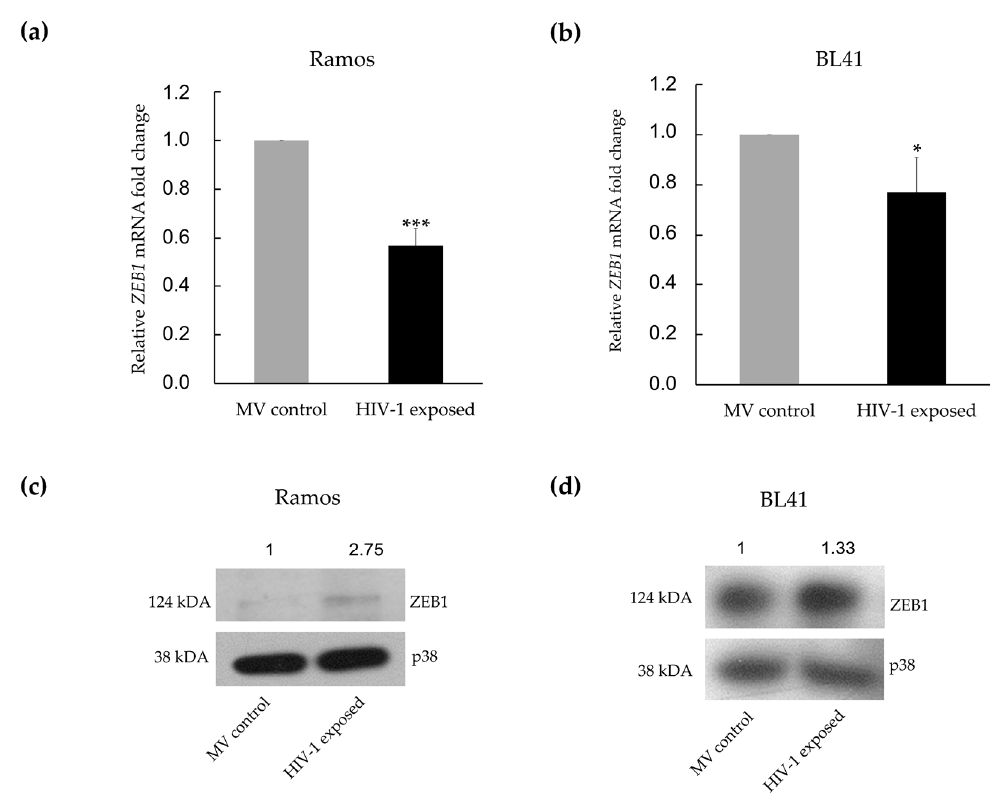
Figure 4. HIV-1 AT-2 deregulates expression of ZEB1 in BL cells. The cells were treated with either HIV-1 AT-2 or microvesicles and thereafter RNA ( a , b ) or protein ( c , d ) was isolated. mRNA expression of ZEB1 in Ramos ( a ) and BL41 ( b ) cells treated with HIV-1 AT-2 as determined by RT-qPCR. Protein expression of ZEB1 in Ramos ( c ) and BL41 ( d ) cells, as determined by Western blotting, using p38 as loading control. For ( a , b ), the delta Ct (2 − ∆∆ Ct ) method was used and Student’s t -test was performed to determine statistical significance. (* p < 0.05, *** p < 0.001) and the error bars represent standard